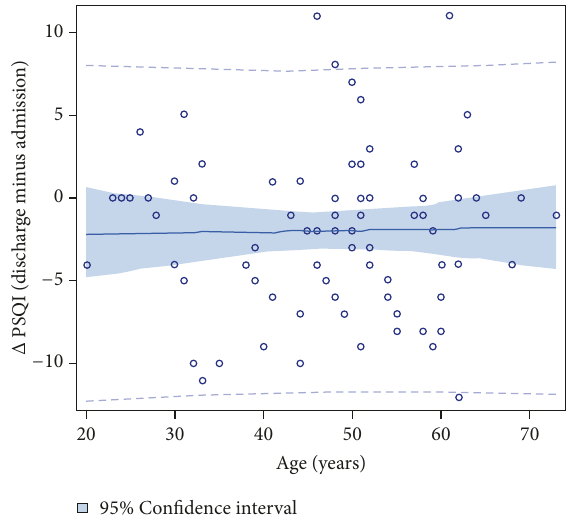
Figure 2: Plot of changes in the PSQI score from admission to dischargebyage . Regression: (cid:2) PSQI=-2.3+0.007 ∗ age(p=0.8785; R 2 = 0.0003).